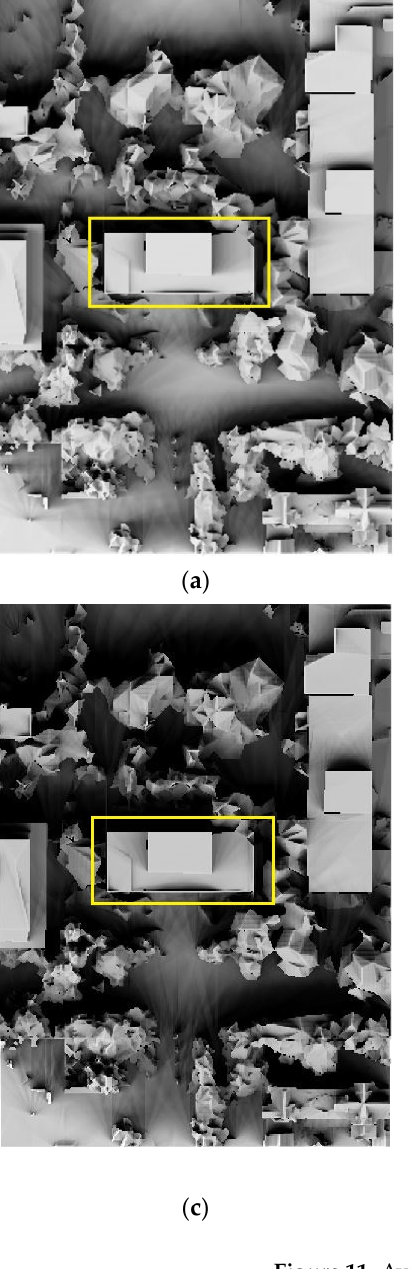
Figure 10. ( a ) Rooftop IDs of the ADMIN building and ( b ) Rooftop IDs of the CAM building. (Im- agery ©2021 Google, Imagery ©2021 Maxar Technologies, Map data ©2021).